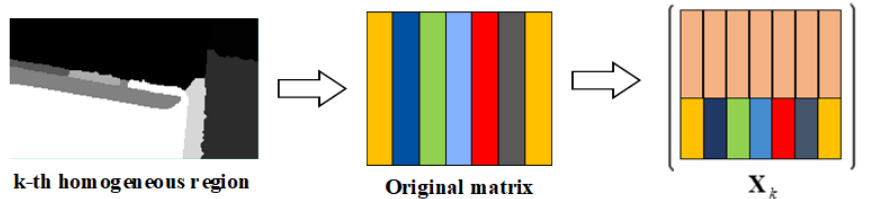
Figure 4. Illustration of low-rank and sparse decomposition.